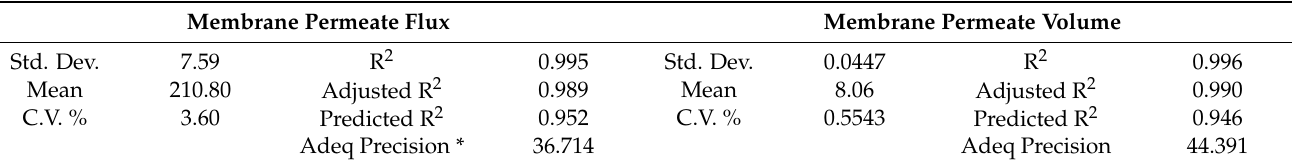
Table 11. Statistics for the fitting